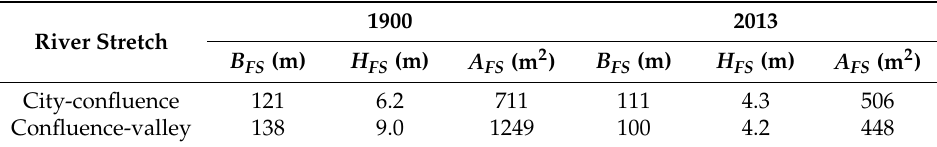
Table 5. Mean width, depth and channel capacity at flood stage in 1900 and